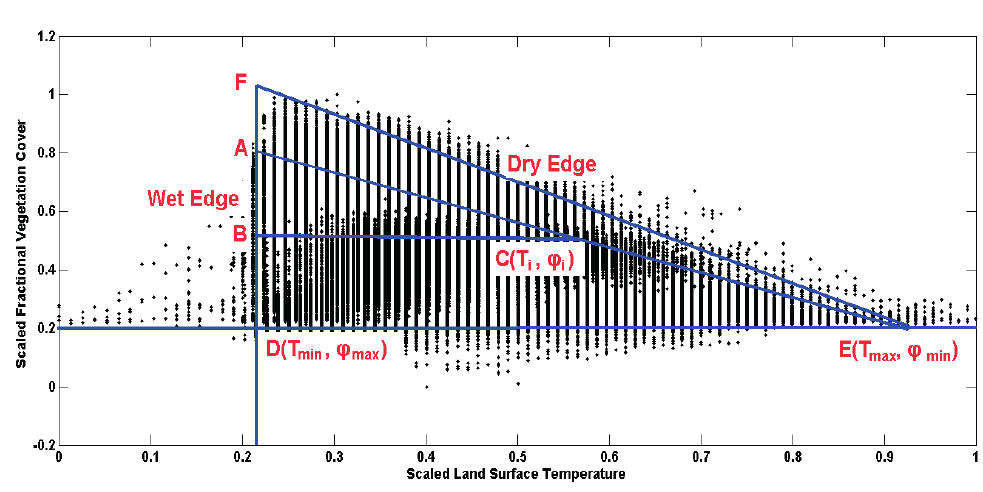
Figure 3. Method to interpolate φ the TVX space. In the similar triangles ABC and ADE, AC/AE = BC/DE. φ